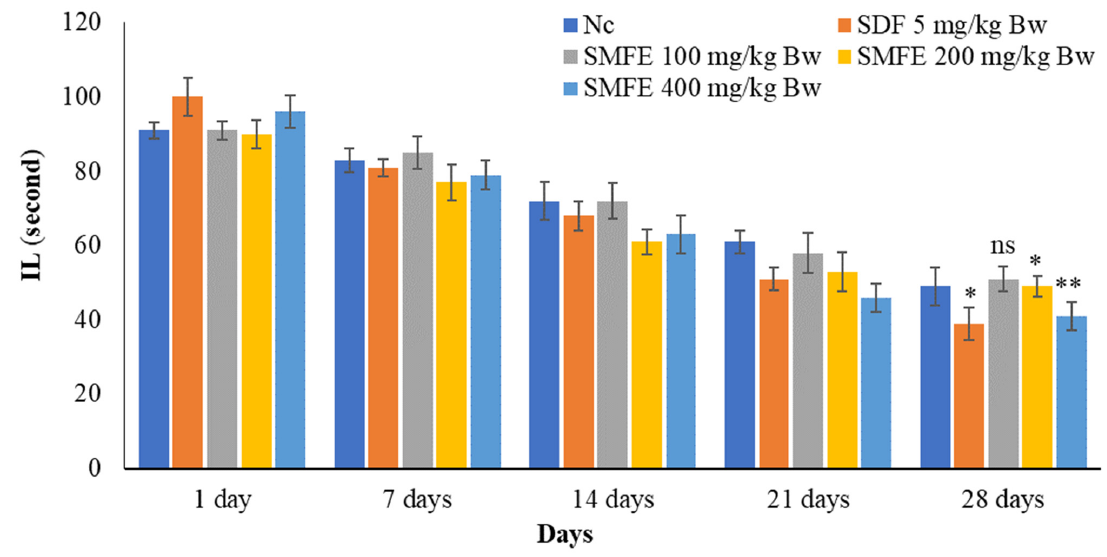
Figure 7. Effect of S. mangifera fruit extract on intromission latency ( n = 6). The values are means ± SEM; * p < 0.05, ** p < 0.1; ns p > 0.05 (followed by Student Dunnett test).